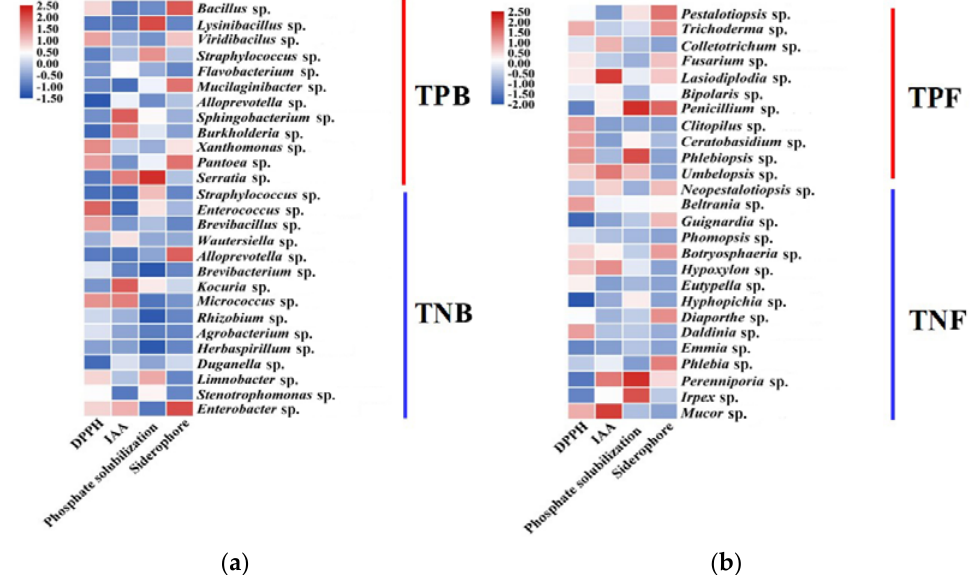
Figure 3. Plant growth promotion traits (PGPT) and triterpenoid synthesis capacity of representative bacterial and fungal isolates. ( a ) Heatmap of PGPT of 27 endophytic bacterial isolates. ( b ) Heatmap of PGPT of 26 endophytic fungal isolates. Three biological replicates per treatment were used for analysis.